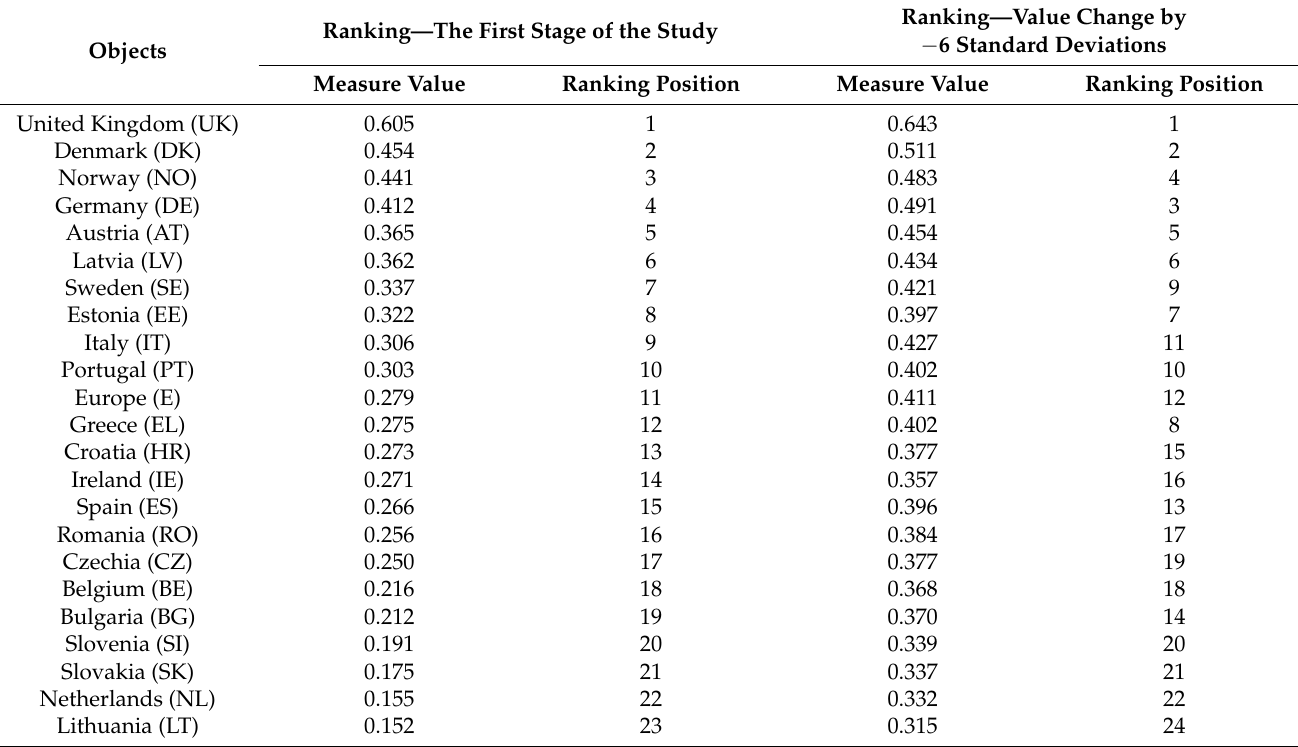
Figure 4. Shifts in the ranking position of objects for the methods: ( a ) TOPSIS; ( b ) VIKOR; ( c ) VMCM. Table 1. Ranking of objects for TOPSIS method after changing value by − 6 of standard deviations.